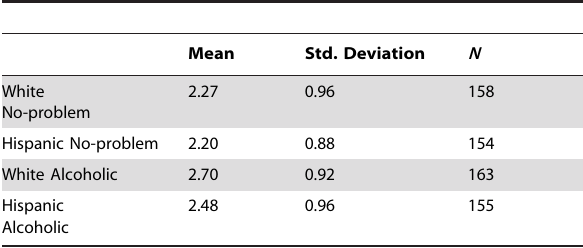
Table 1. Means and Standard Deviations Showing the Black Sheep